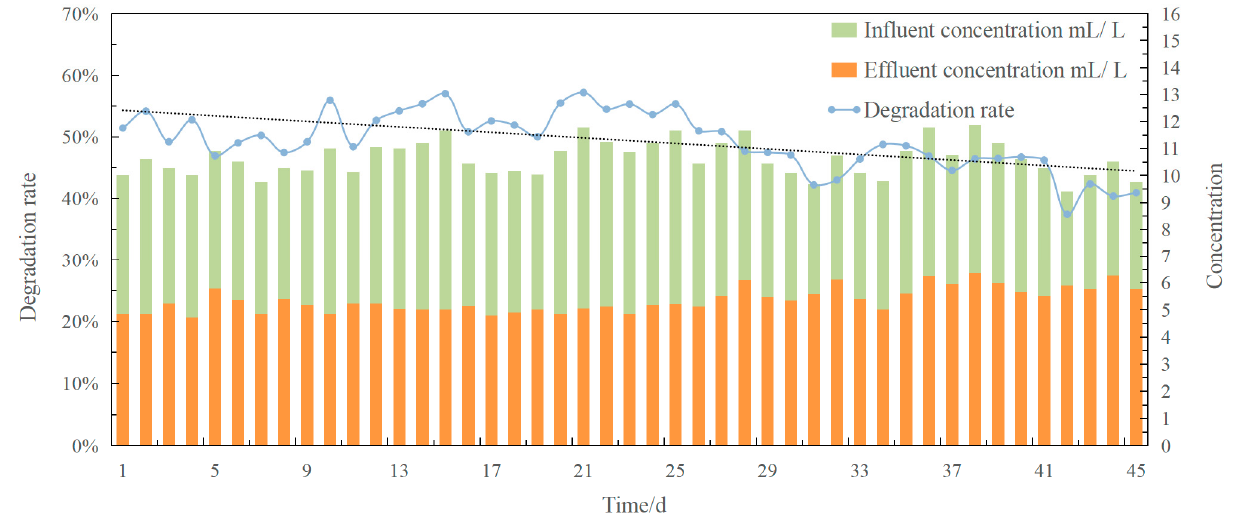
Figure 1. The degradation rate of the immobilized petroleum–degrading bacteria beads in the bioreactor over 45 days. (The influent concentrations and effluent concentrations of diesel are shown in green and yellow, respectively.)